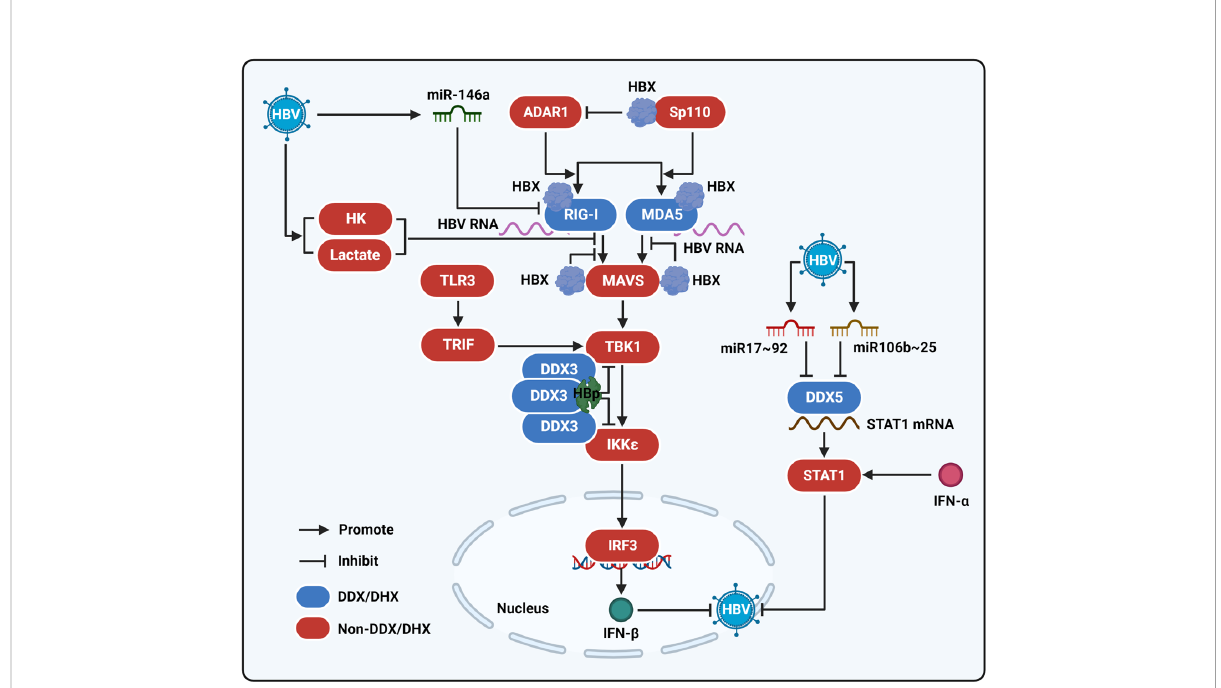
FIGURE 2 The interaction of HBV with DEAD/H-box helicases to regulate the innate immune response. MDA5 and RIG-I interact with HBV RNA and function as viral RNA sensors to sensitize the RLR signaling pathway. After being stimulated by HBV RNA, RIG-I and MDA5 activate MAVS and then sensitize TBK1. Next, TBK1 stimulates the activation of IKK ϵ and IRF3 to produce IFN- b and then repress HBV infection. HBX can interact with MDA5, RIG-I, and MAVS to inhibit their interactions and thereby reduce the activation of the RLR signaling pathway. ADAR1 and Sp110 mediated by HBX also contribute to the modulation of the RIG-I/MDA5-mediated RLR signaling pathway. HBp could interact with DDX3 to suppress the binding of DDX3 to TBK1 or IKK ϵ and inhibit the RIG-I/MDA5-mediated RLR signaling pathway, as well as the TLR3 signaling pathway. In addition, HBV can induce miR-164a expression to inhibit RIG-I-mediated innate immune response. HBV upregulates miR106b~25 and miR17~92 clusters to repress DDX5, which binds to STAT1 mRNA and regulates STAT1 translation when the cells are stimulated by IFN- a to suppress viral infection. HBV promotes the activity of hexokinase (HK) and the production of lactate to inhibit the interaction between RIG-I and